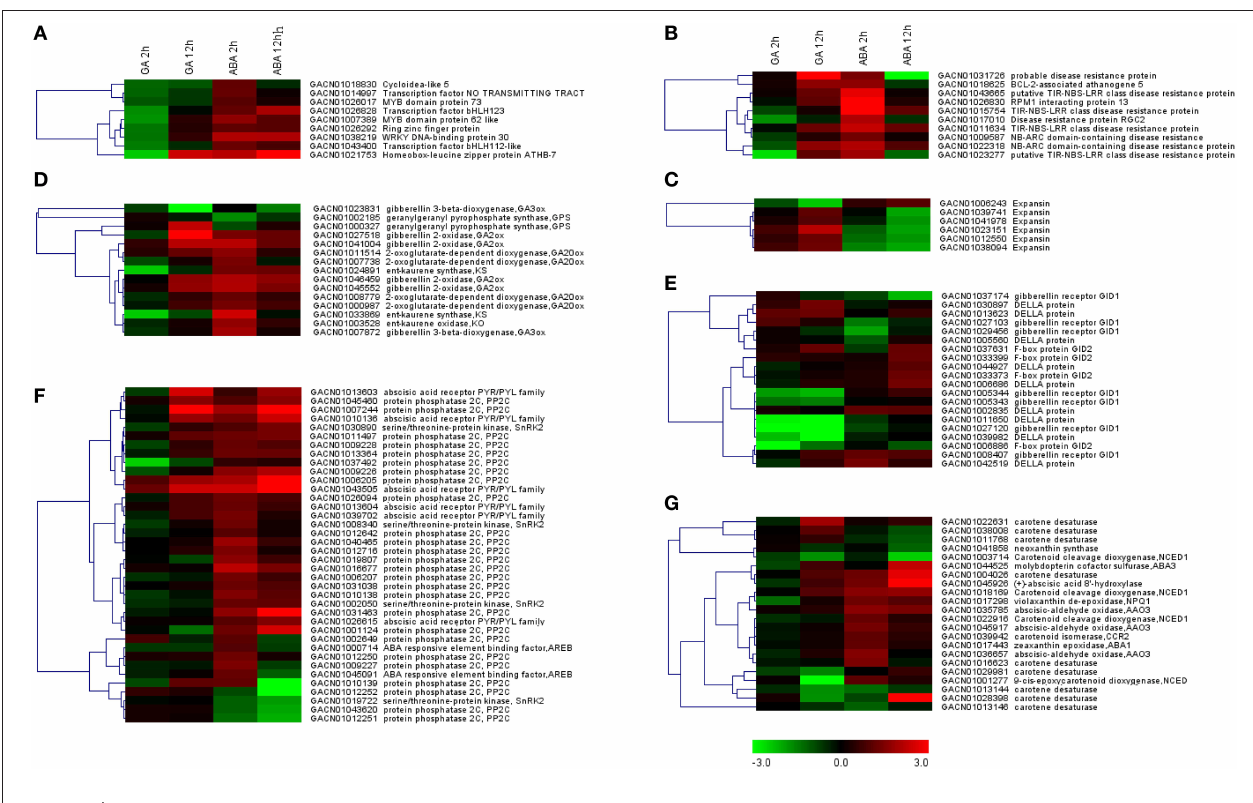
DEGs associated with regulation of transcription. (B,C) DEGs with the GO terms of “cell death” or “cell wall organization.” (D–G) Unigenes involved in pathways related to gibberellin biosynthesis (D) or signaling (E) , or ABA biosynthesis (G) or signaling (F)